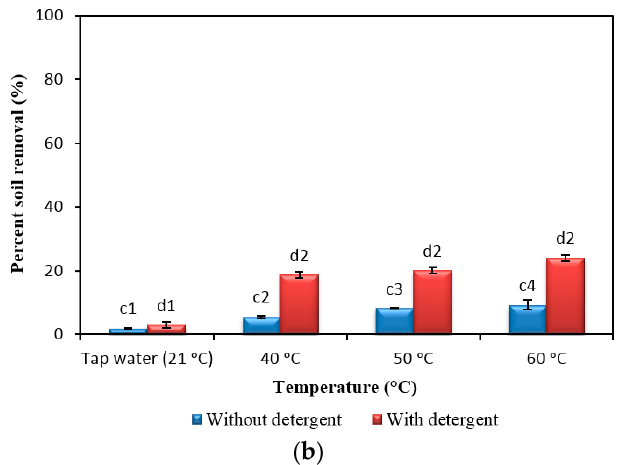
Figure 1. Efficiency of formulated detergent. The detergent contained 7% surfactant, 3% builders, 5% dispersing agent and was buffered with glycine-carbonate (pH 9.25) and tested in ( a ) Soft water (0 ppm CaCO 3 ) and ( b ) Hard water (350 ppm CaCO 3 ) at 40 °C, 50 °C and 60 °C. Tap water (21 °C) used as a control. Note: Superscript a2, b2, c2, c3, c4 and d2 indicated groups that showed a significant difference between their respective groups. All superscripts were obtained using post-hoc tests as shown in Table S1. Data are means ± standard deviation of three determinations and indicated as an error bar.